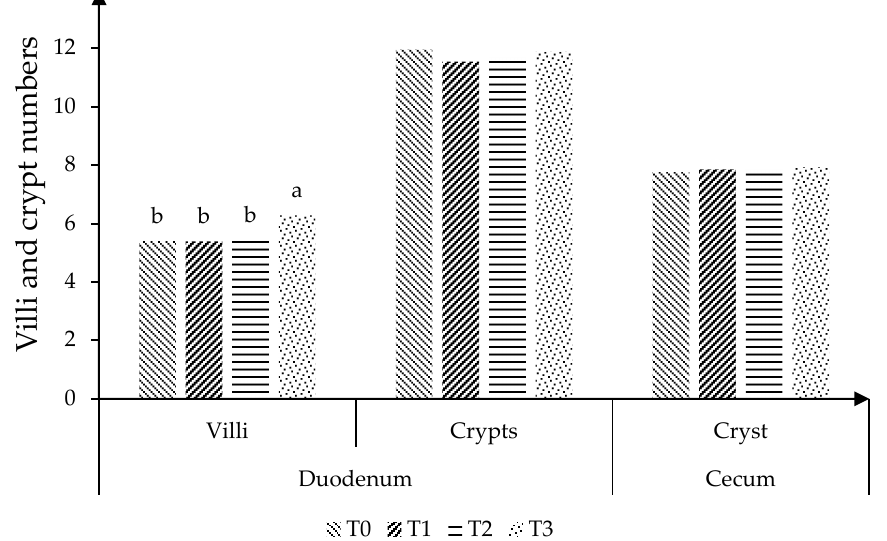
Figure 1. Effect of A. tequilana stem powder on the number of villi (SEM ± 0.132; p -value 0.001) and crypts in the duodenum (SEM ± 0.494; p -value 0.088) and on the crypts number (SEM ± 0.259; p -value 0.664) in the cecum of rabbits. a,b Means with different letters among treatments differ at p < 0.05.